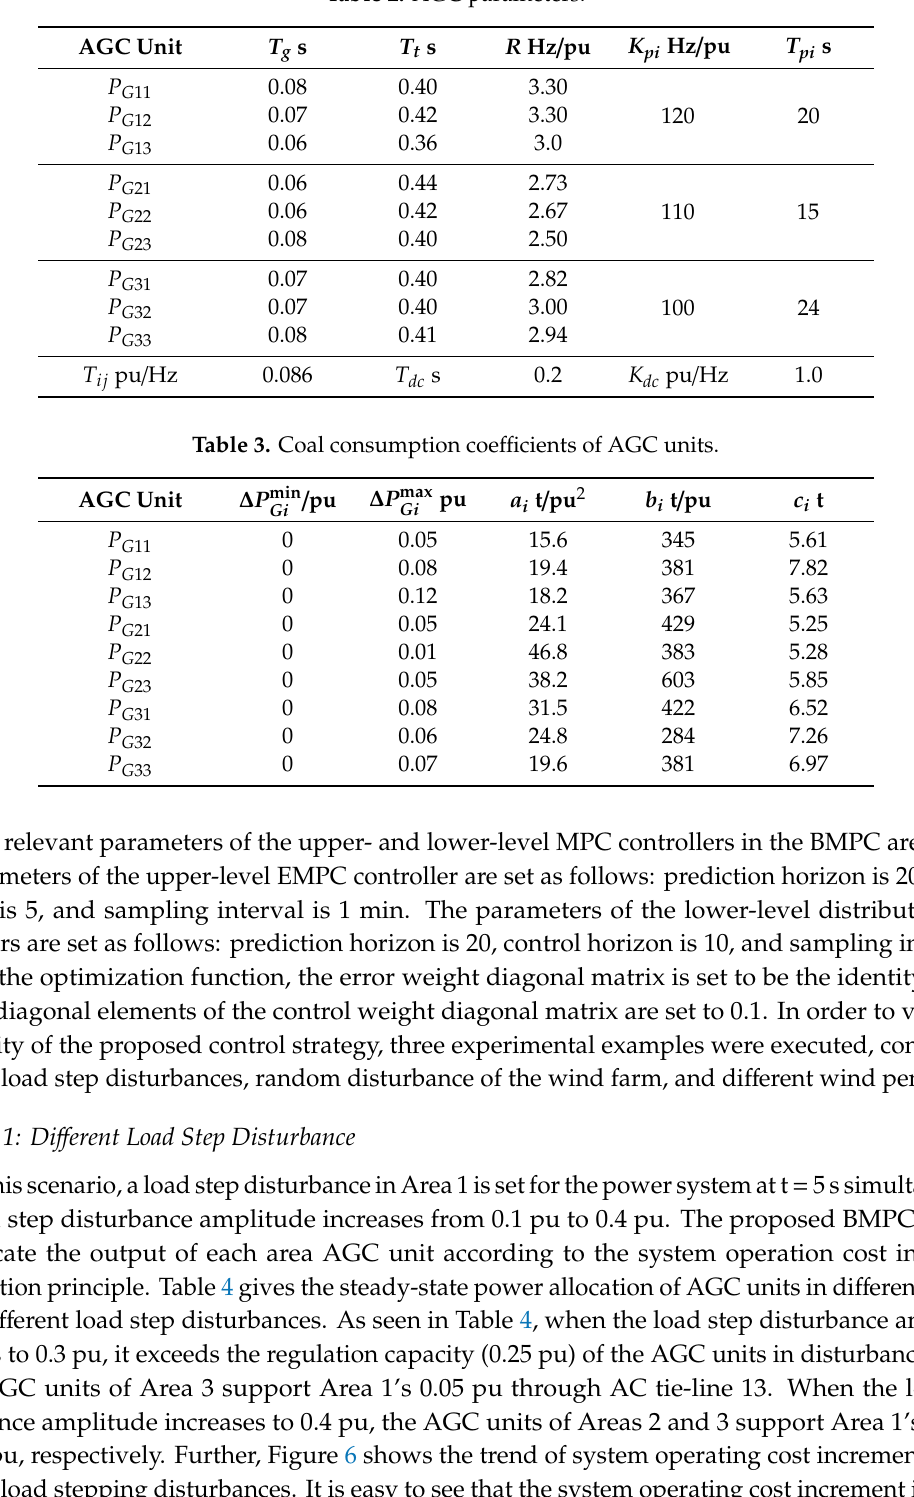
Table 2. AGC parameters.